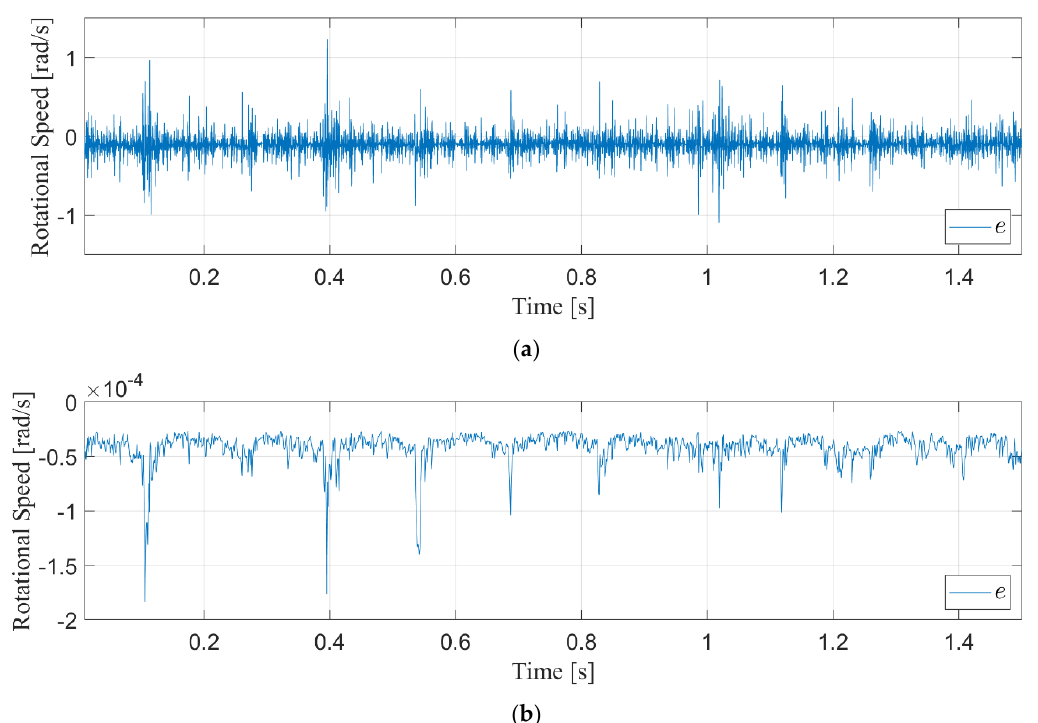
Figure 7. Rotational speed error for linear controller ( a ) and nonlinear controller ( b ). Table 5. RMS speed control errors for linear and nonlinear controllers.